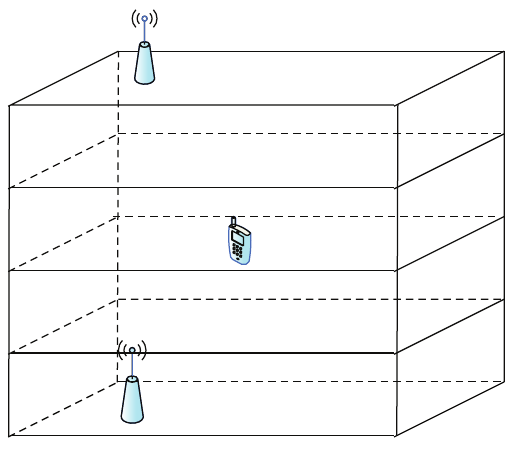
Figure 1: Basic model of